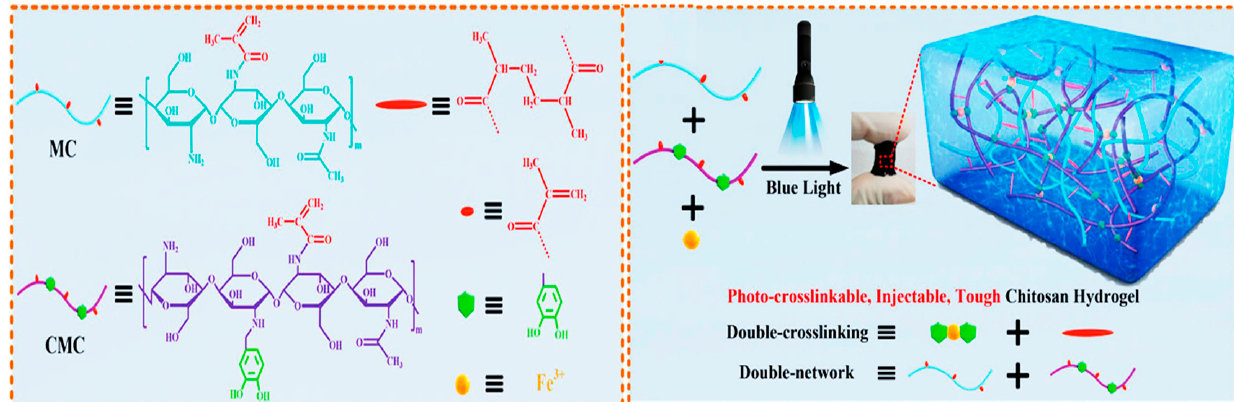
Figure 16. Schematic illustration on the fabrication of a photo-crosslinkable, injectable chitosan-based hydrogel with enhanced tissue adhesion and antibacterial activity.